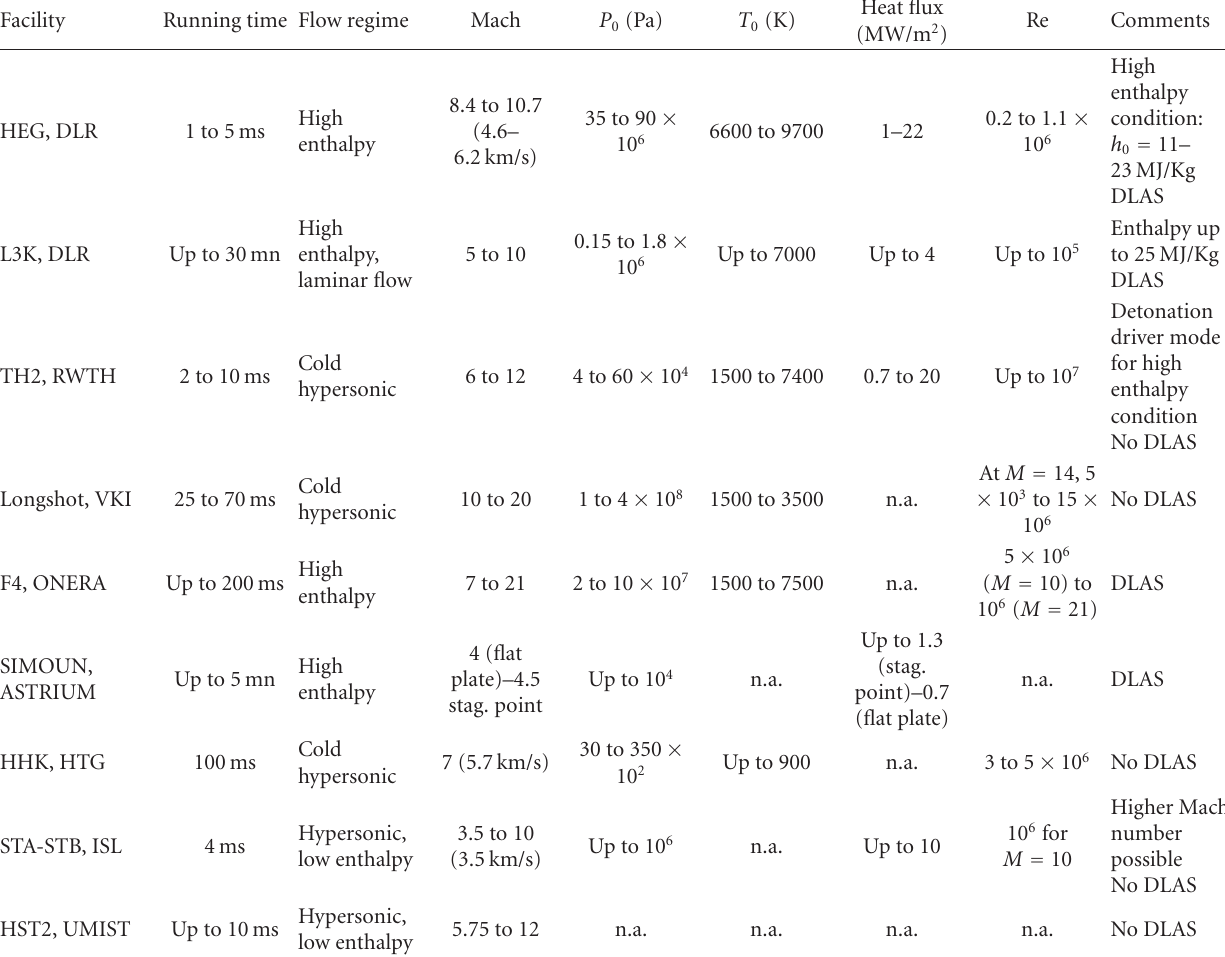
Table 2: Capabilities of some available European installations for investigation of aerothermodynamics during a Martian entry.